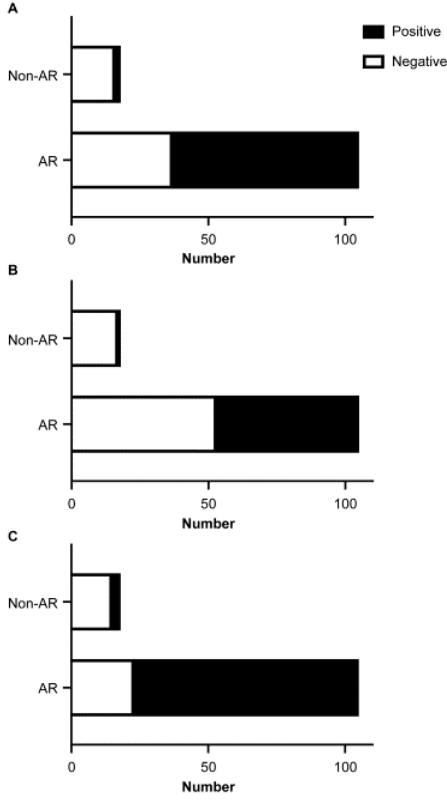
Figure 2. Comparison of the detection rates of total IgE in nasal fluid using the AW test and the conventional nasal smear examination for eosinophils between the AR and non-AR patients: ( A ): Total IgE in nasal fluid. ( B ): Eosinophils in nasal smear. ( C ): Combination of the two examinations. Table 1. Comparison of the sensitivity and specificity for the diagnosis of allergic rhinitis (AR) between the detection of total IgE in nasal fluid using the AW test and the conventional nasal smear examination for eosinophils.